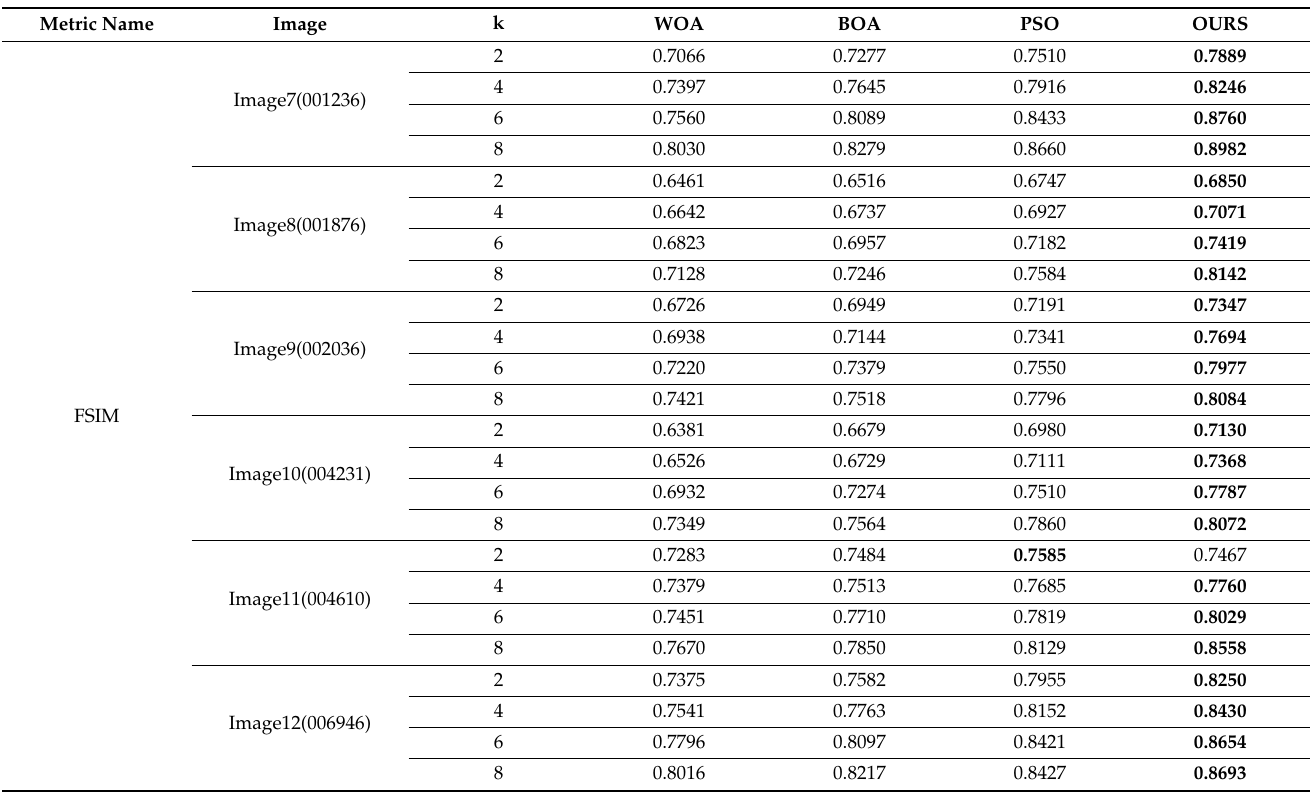
Table 9. Comparison of FSIM in Images g–l.